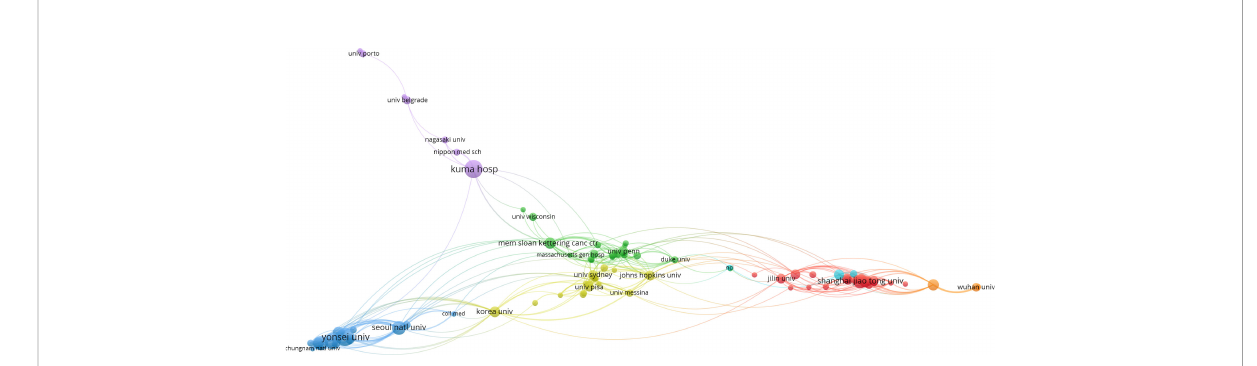
FIGURE 4 The visualization of co-authorships networks of the top 99 most productive institutions in PTMC fi